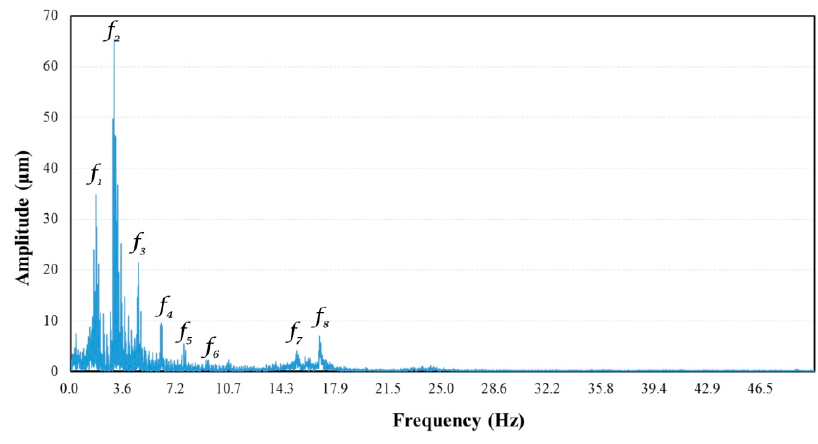
Figure 5. Frequency spectrums of vibration at the mid of stator frame.